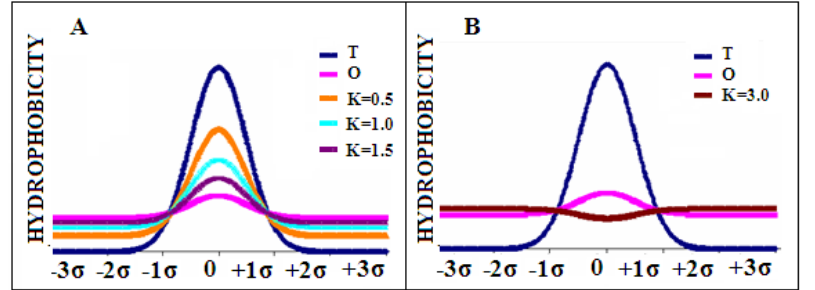
Figure 11. ( A )—the comparison of plots of distributions M for the three different values of K ; ( B )—plot of distribution M for a very high value of K (3.0). The distributions T and O are marked in navy blue and pink respectively.